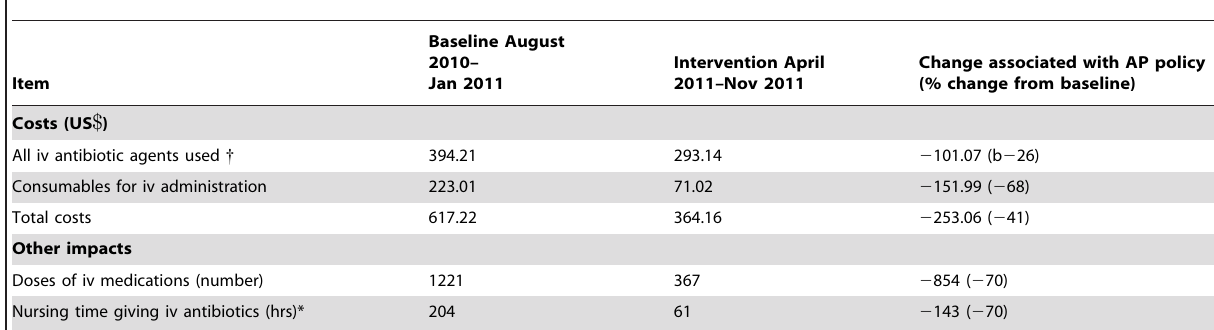
Table 3. Financial and other impacts associated with provision of surgical antibiotic prophylaxis, per 100 operations.